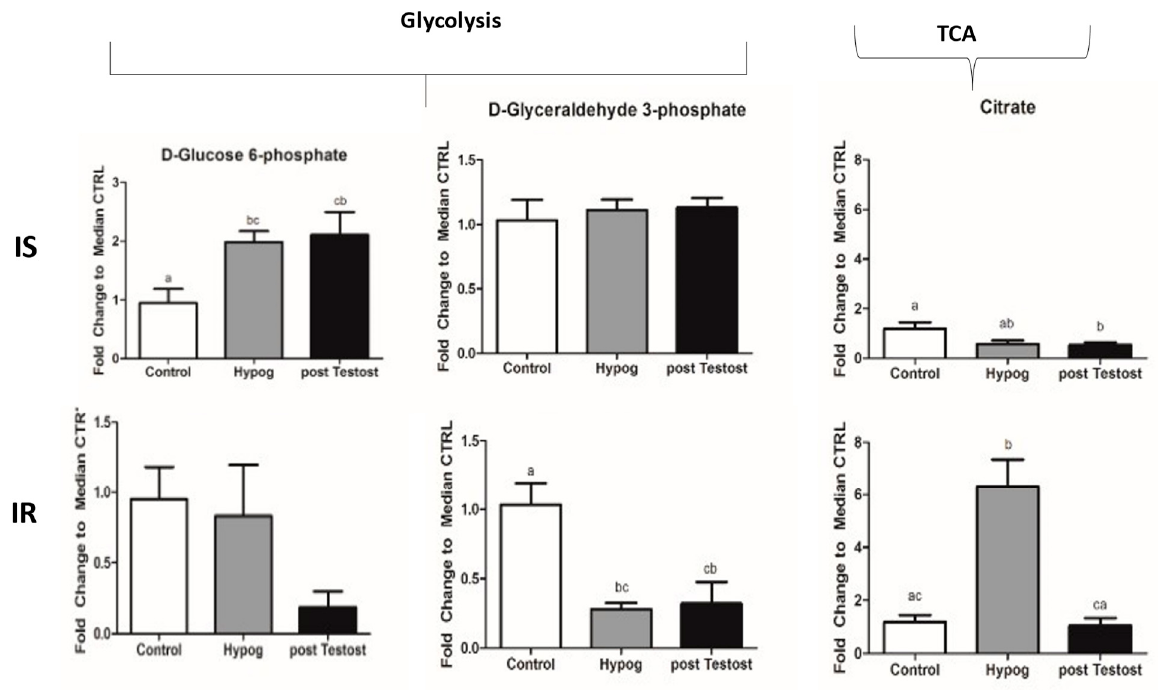
Figure 2. Representative intermediates of glycolysis and the TCA cycle, shown as differences between control subjects and hypogonadal patients, before and after TRT. The data shown are from previous published papers [53,54].